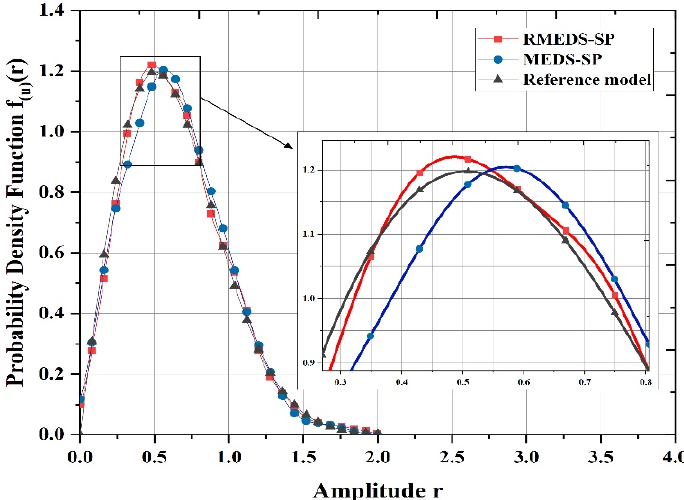
Figure 8. PDF of the amplitude distribution of different models.